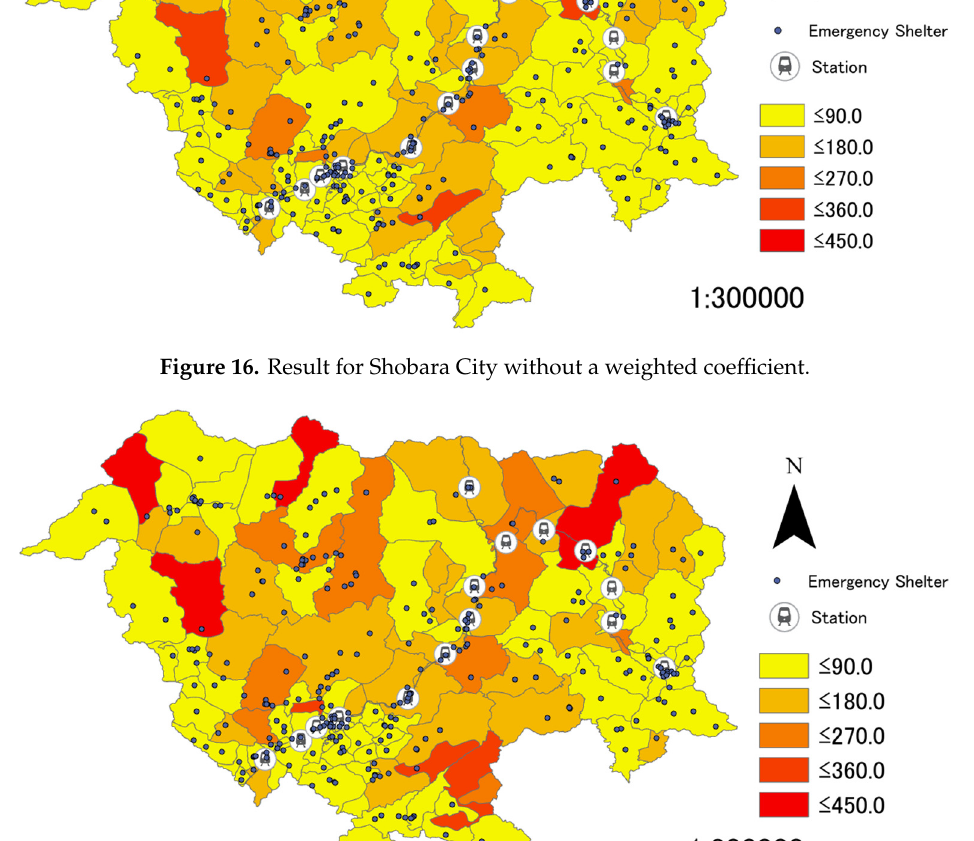
Figure 17. Result for Shobara City with the specialization coefficient of elderly population as a weighted coefficient.